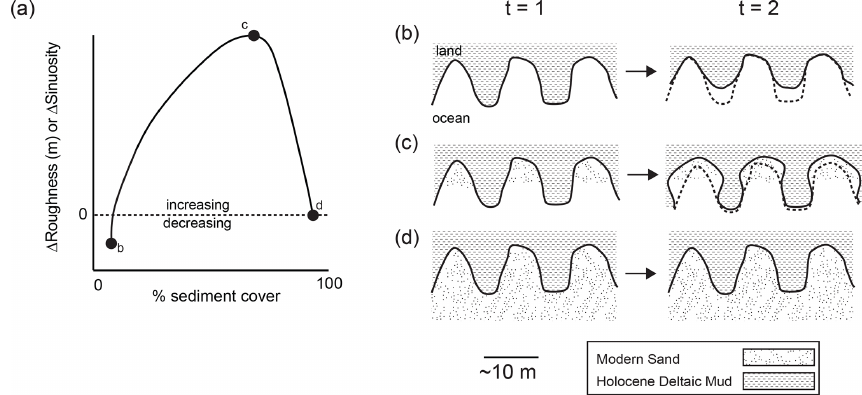
Figure 11. (a) Conceptual diagram of the relationship between change in cliff roughness or sinuosity with sediment cover percentage. Posi- tive represents increasing roughness or sinuosity, and negative represents decreasing roughness or sinuosity. Plan view conceptual diagrams of cliff face erosion with (b) no sediment cover, (c) intermediate sediment cover, or (d) 100% sediment cover. The dashed line represents t = 1 cliff face. Land is at the top and ocean is at the bottom for each